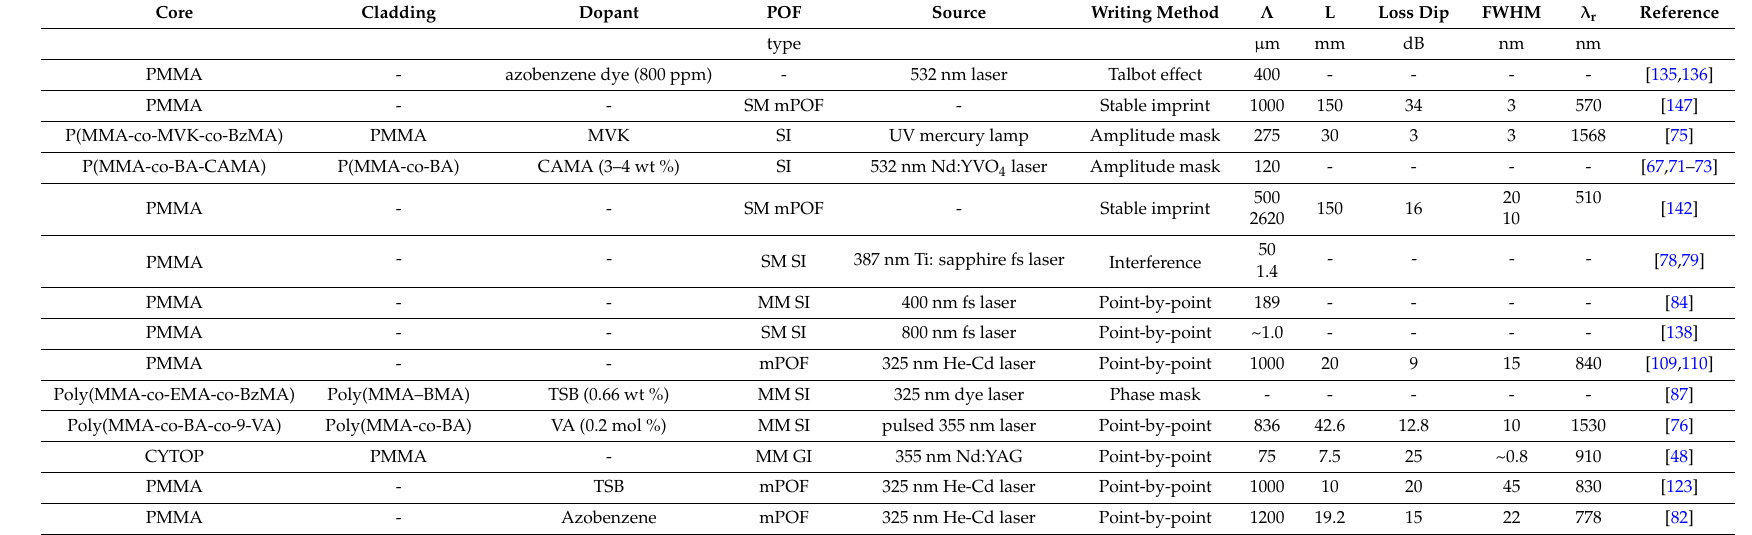
Table 4. The fabrication conditions and the main characteristics of LPGs in